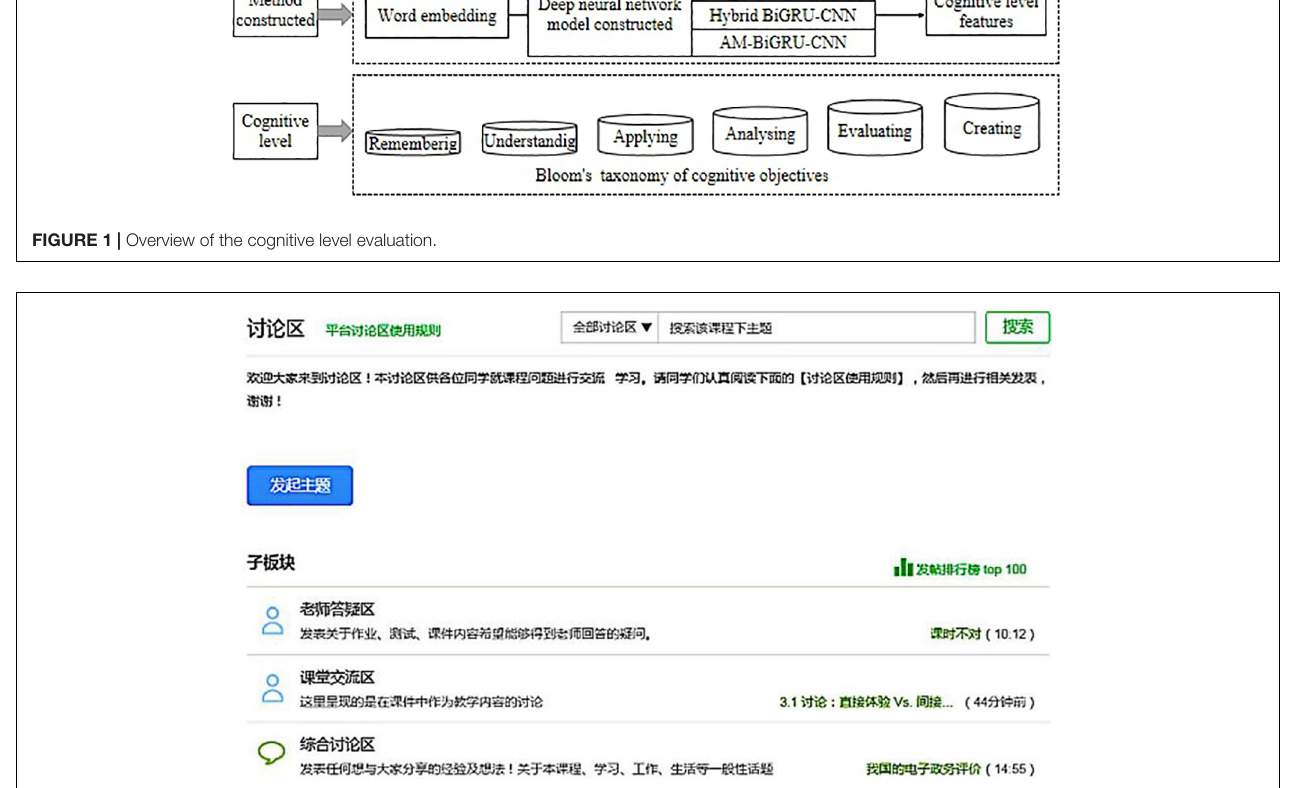
FIGURE 2 | The structure of the discussion